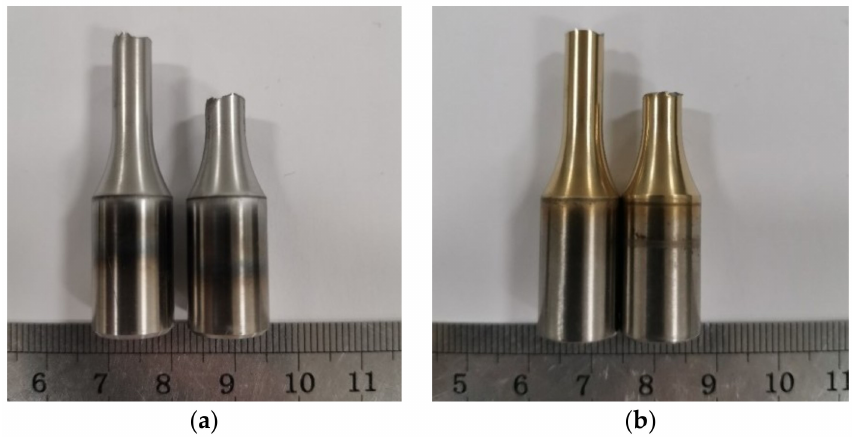
Figure 9. Outward appearance of the CrN and TiN coated samples after fatigue tests. ( a ) CrN coated fatigue specimen, ( b ) TiN coated fatigue specimen.